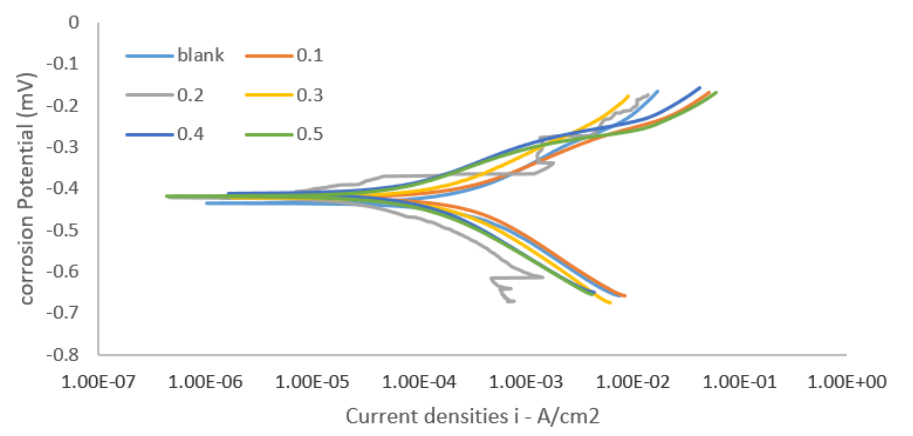
Figure 11: Corrosion potential against corrosion current density (Prosopis Africana seed extract)